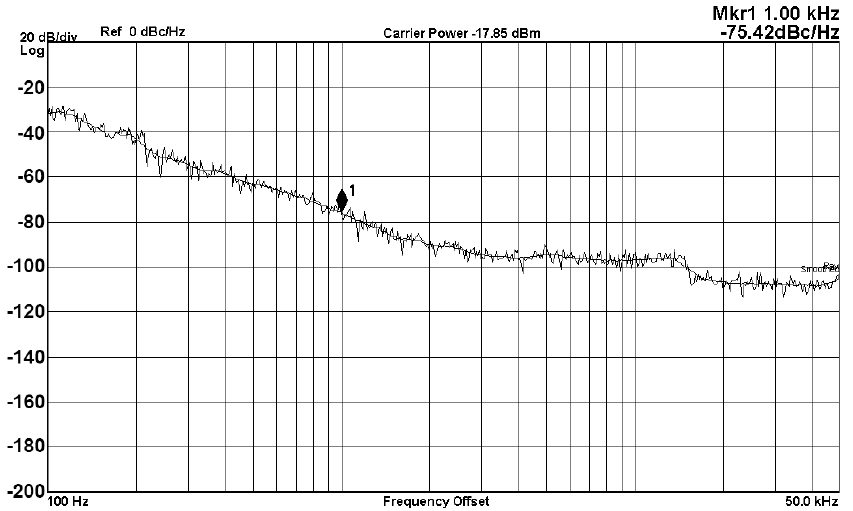
Figure 27. The frequency of oscillation (FO) theoretical, simulated and experimental results by varying the value of g m2 .